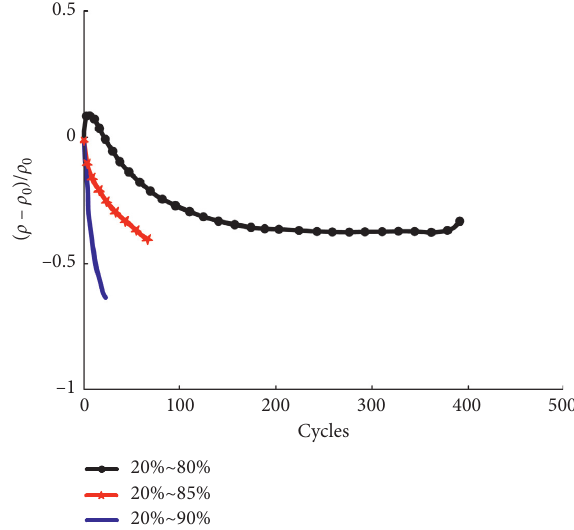
Figure 8: Resistivity evolution law of sandstone under different stress